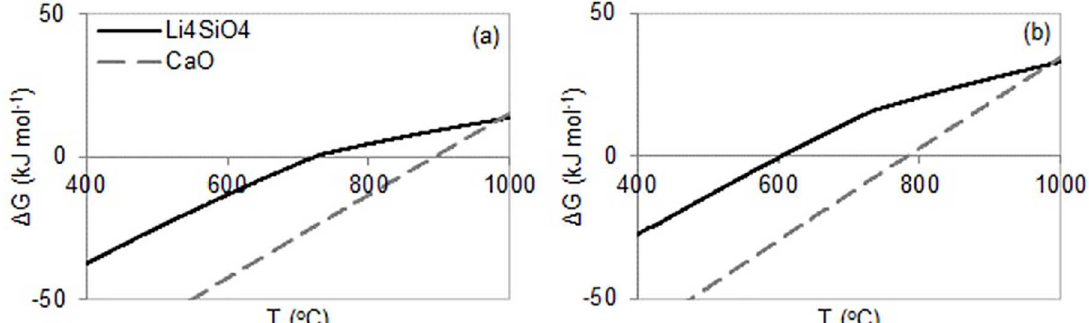
SiO and CaO as a function of temperature, for CO 4 4